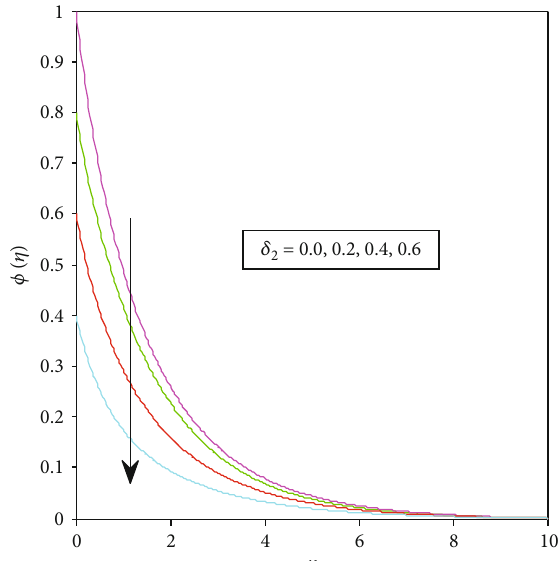
Figure 20: Concentration distribution for di ff erent values of the solutant strati fi cation parameter.